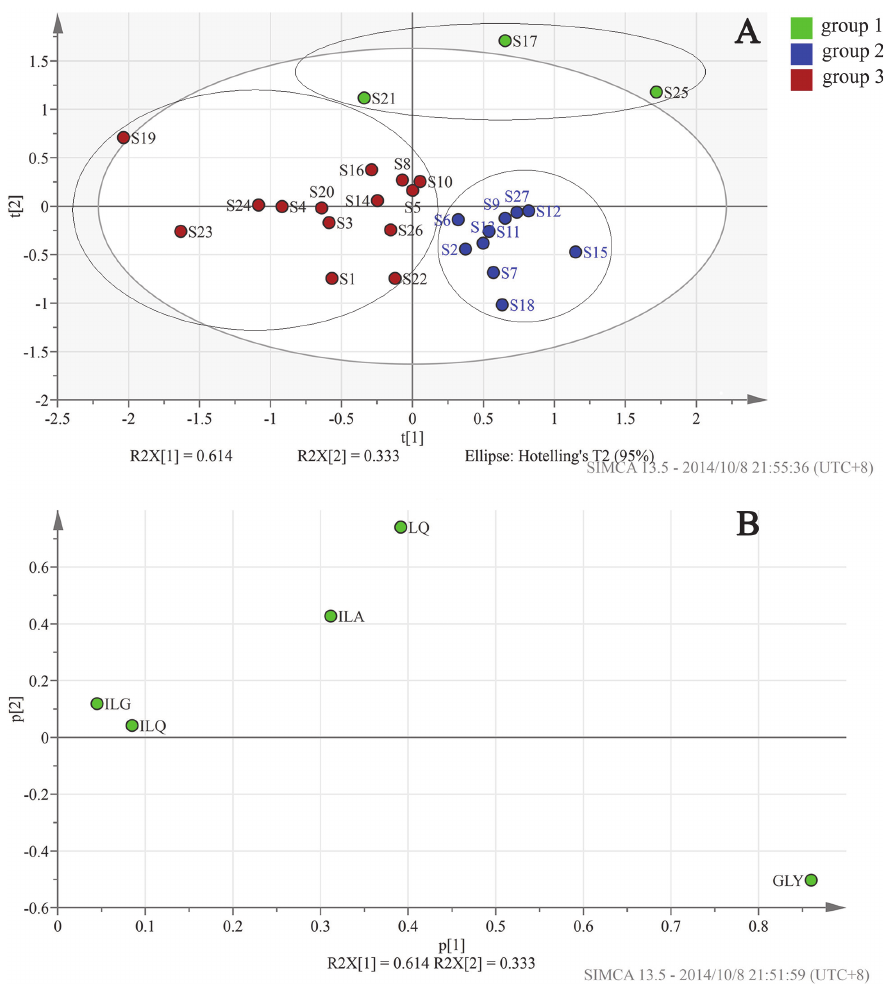
Fig 4. PCA score plot (A) and loading plot (B) of 27 batches of CBAT samples on the basis of the contents of the 5 marker compounds.